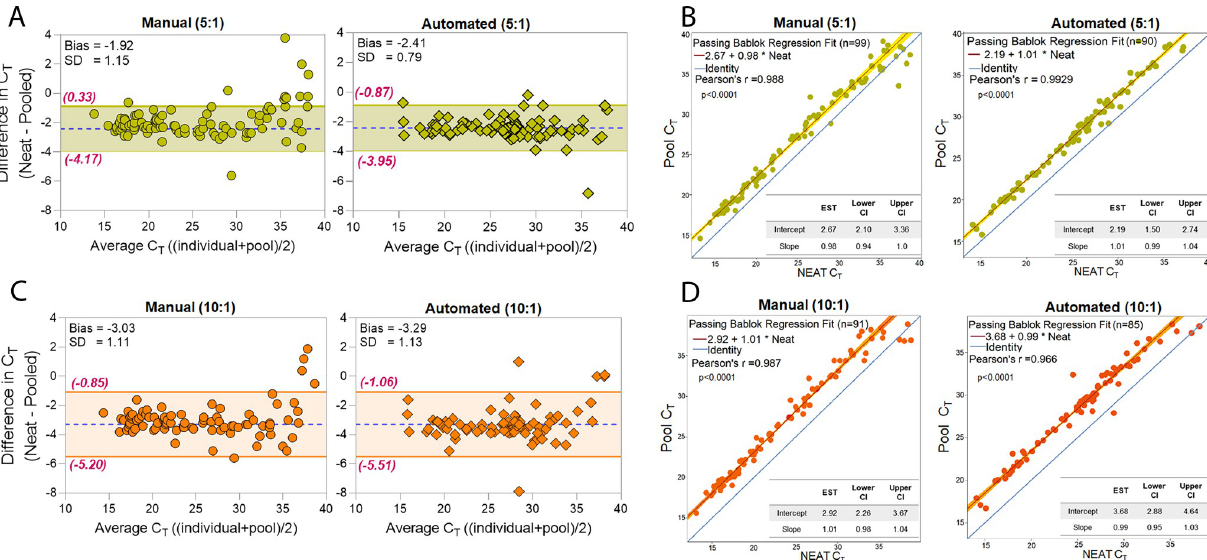
Fig 4. Linearity of the Panther Fusion 1 SARS-CoV-2 assay for pooled testing. (A)(C) Bland-Altman plot and (B)(D) Passing-Bablok regression plots are presented for 5:1 or 10:1 pooled testing versus neat with the Panther Fusion 1 SARS-CoV-2 assay. For the Bland-Altman plots, the area between the dotted lines (green or orange) indicates the 95% limits of agreement. For the Passing-Bablok regression, the confidence interval is shaded (green or orange) and the blue line indicates the line of identity. The slope and intercept of the regression line are reported in the left top of each panel.